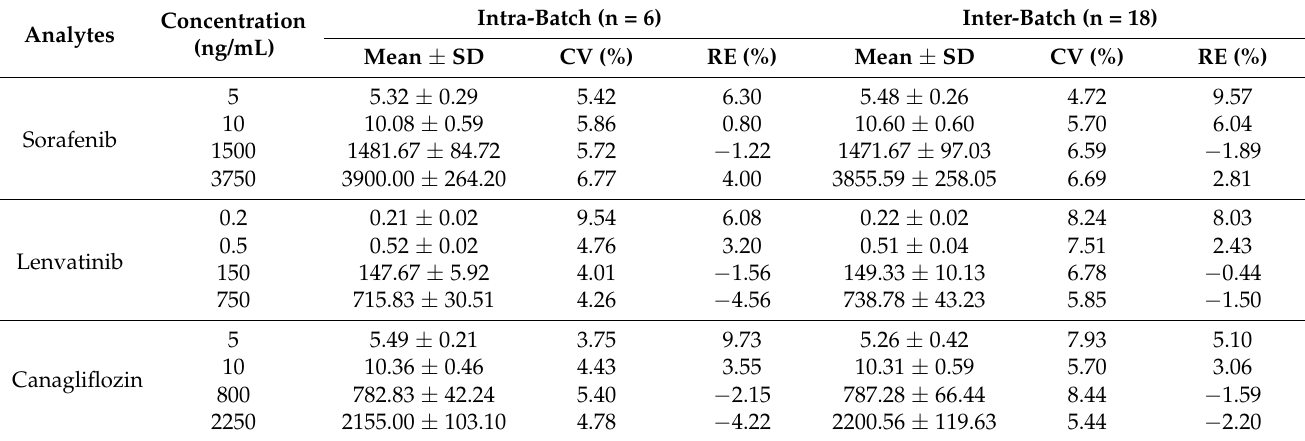
Table 1. Precision and accuracy of sorafenib, lenvatinib, and canagliflozin in rat plasma.